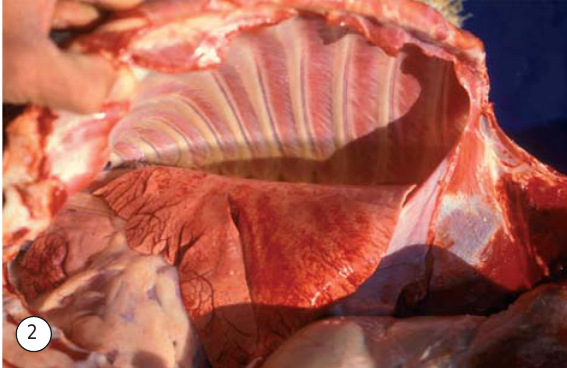
FIG. 1 Hydropericardium in a sheep that died after a long latent period